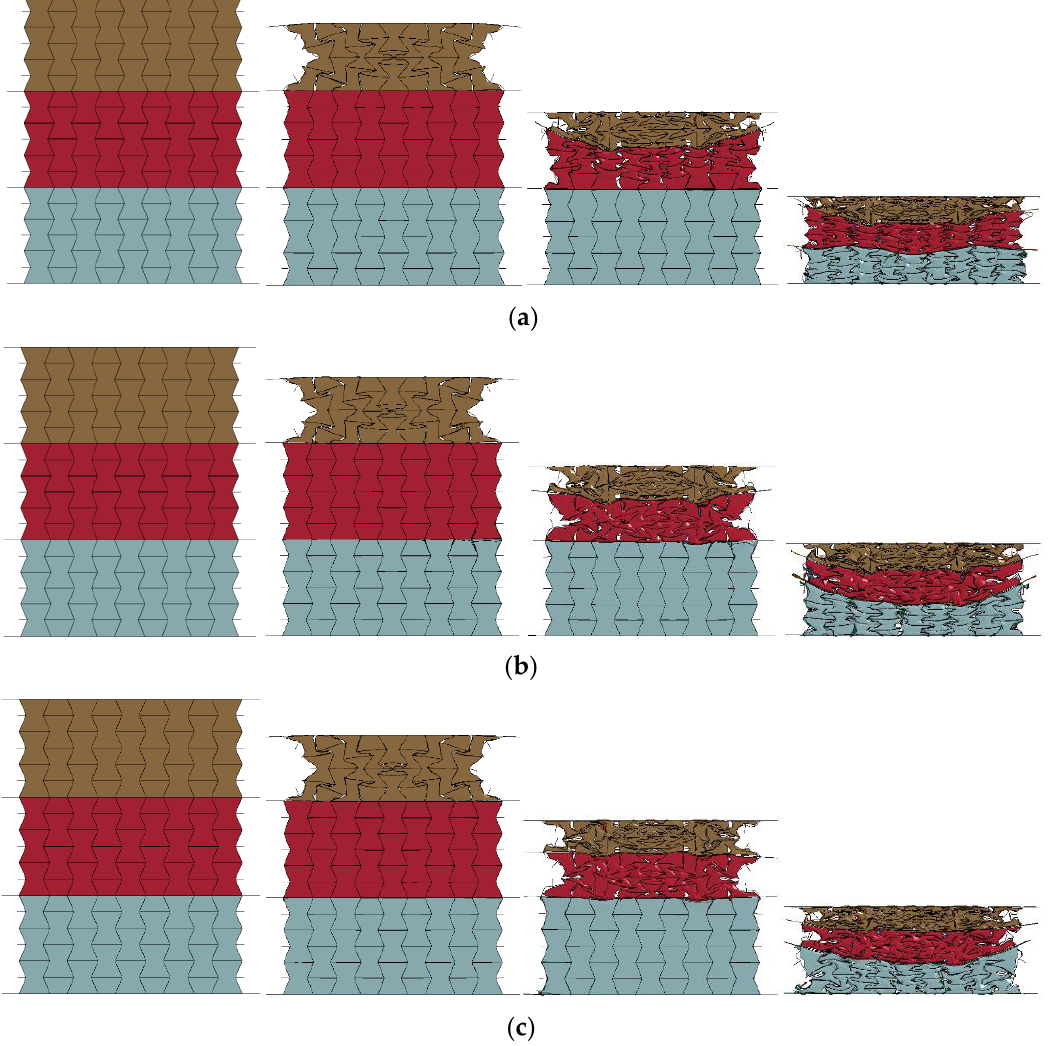
Figure 21. The response modes of the composites with foam concrete density gradient under compression strokes of 0, 15, 55, and 95 mm (1 m/s): ( a ) t = 0.3:0.3:0.3 and ρ = 408:575:848; ( b ) t = 0.4:0.4:0.4 and ρ = 408:575:848; ( c ) t = 0.5:0.5:0.5 and ρ = 408:575:848.